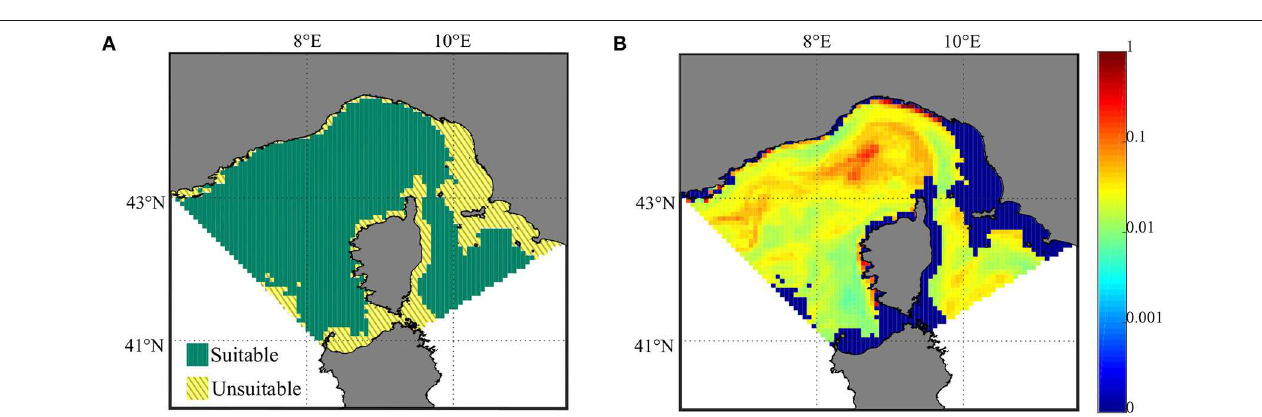
FIGURE 4 | Indicators of inter-annual variability in plastic distribution (hazard component). (A) Partitioning by source type of particles retained in the Pelagos Sanctuary each year during the simulated period. Percentages refer to the total number of particles released in a year from the relevant type of source. (B) Inter-annual CV of plastic density over the Sanctuary area in 2000–2010.